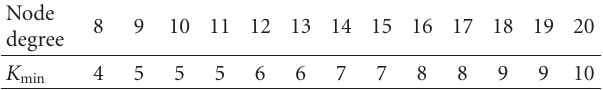
Table 2: The approximate minimum number of clusters as it varies with node degree, from (2). The approximate K max = 10, from (5) at relaxed delay